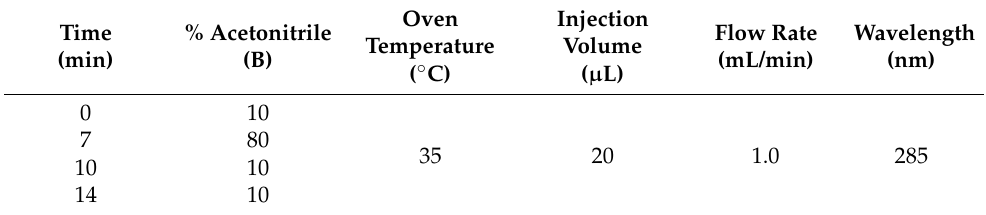
Table 1. Chromatographic conditions for CBZ